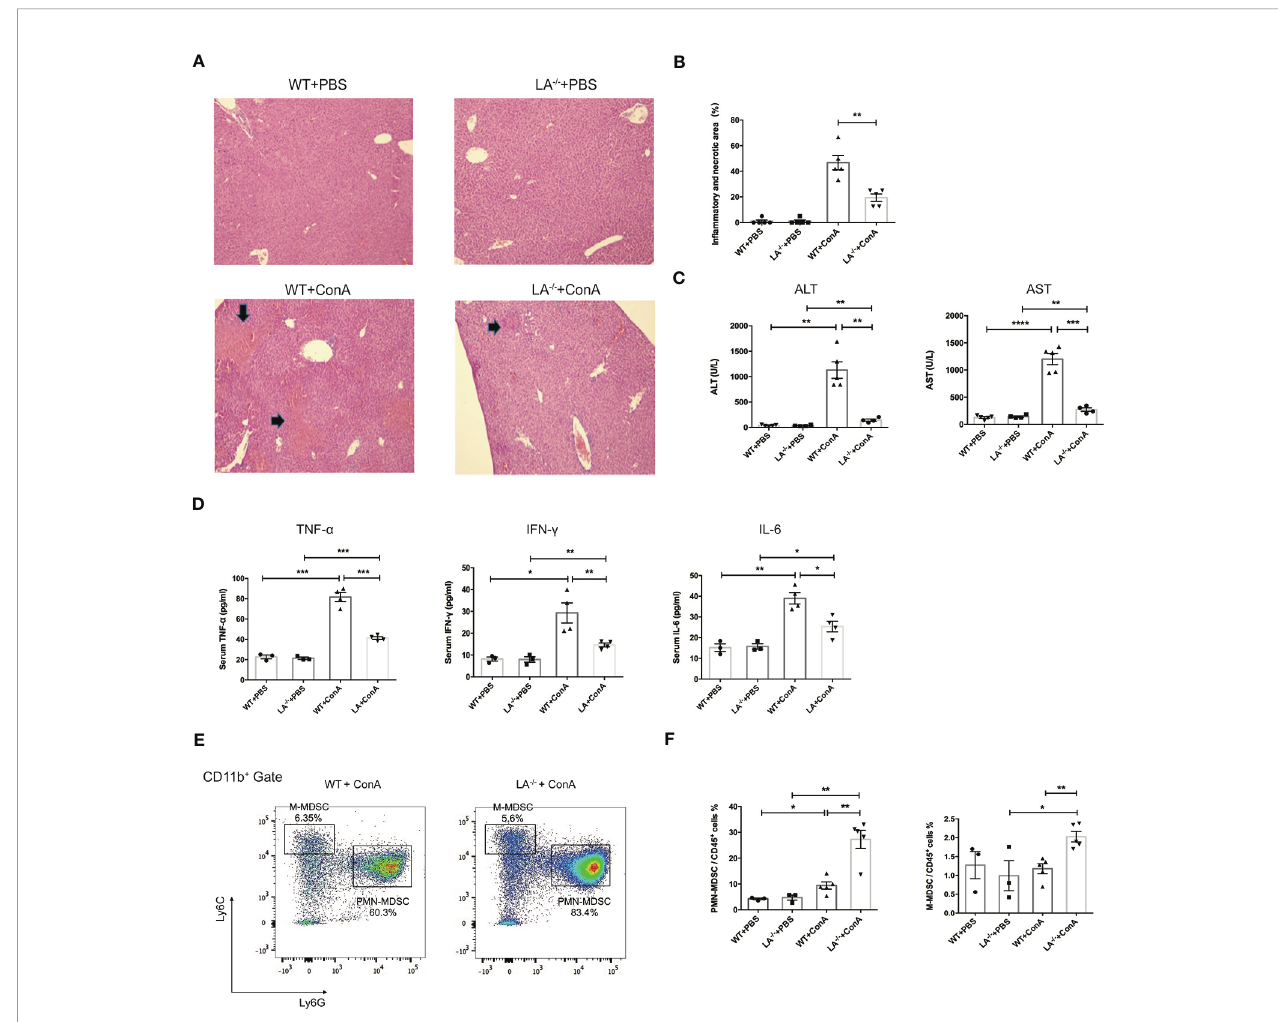
FIGURE 2 | Knockout of LXR a mitigated ConA-induced hepatitis by facilitating expansion of MDSCs. (A) Representative H&E staining (×100) of livers in WT or LXR a − / − mice injected i.v. with PBS or ConA. Mice were killed 24 h after ConA administration. (B) Quanti fi cation of in fl ammatory and necrotic area in each group. (C) Serum levels of ALT and AST. (D) Serum levels of in fl ammatory cytokines, including TNF- a , IFN- g , and IL-6. (E) Liver MNCs harvested from WT and LXR a − / − mice at 18 h after ConA challenge were analyzed by fl ow cytometry for the frequency of MDSCs. (F) Quanti fi cation of hepatic PMN-MDSCs and M-MDSCs in each group ( n = 3 – 6 per group). Data are presented as mean ± SEM. * p > 0.05, ** p < 0.01, *** p < 0.001, and **** p <